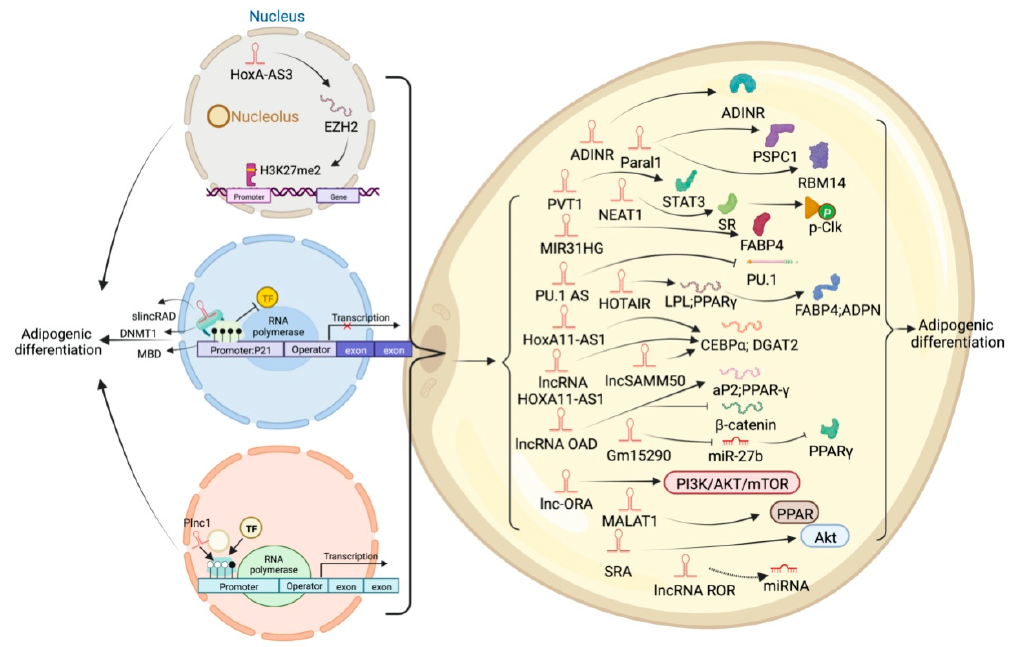
Figure 4. Schematic diagram of the biological function of lncRNA that inhibits or participates in the deposition of white fat lipids.